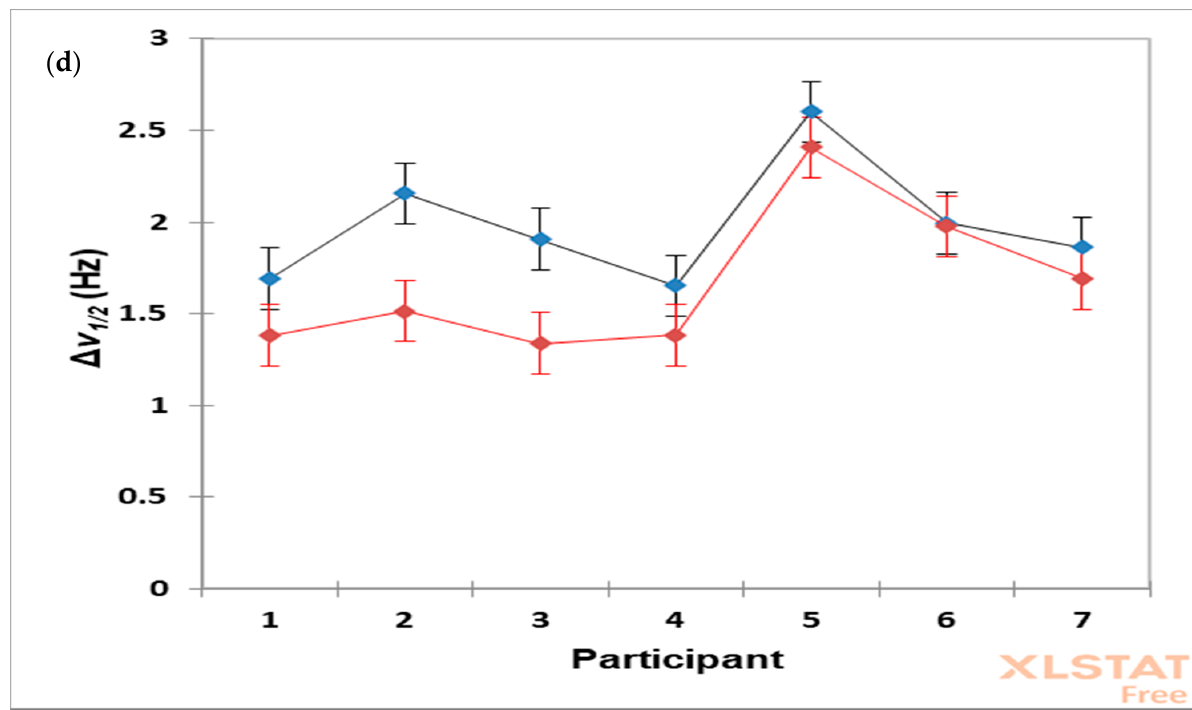
Figure 4. ( a – c ), Expanded 1.30–1.50 ppm regions of the 600 MHz metnoesy 1D 1 H NMR spectra of WMS supernatant samples collected from n = 3 of the participants recruited to this case study. Samples were prepared and 1 NMR spectra acquired according to the method described in [3]. ( d ) Plots of mean ±95% confidence interval (CI) values for the resonance line-widths at half-height ( Δ v 1/2 ) for the lactate (red) and alanine (dark blue) resonances present in the 1 H NMR spectra of WMS supernatant samples donated by n = 7 participants.